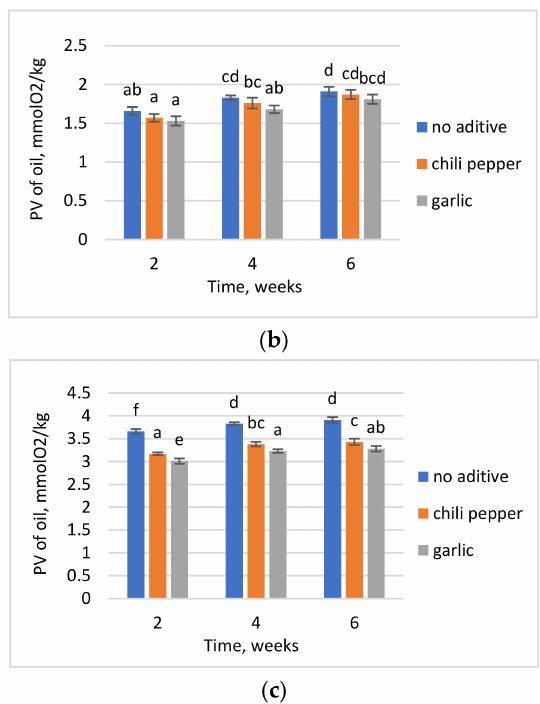
Figure 2. Effect of additives on the peroxide value of stored oils: ( a )—flax seed oil; ( b )—hemp seed oil; ( c )—black cumin seed oil. The values designated by the different small letters are significantly different ( α = 0.05).